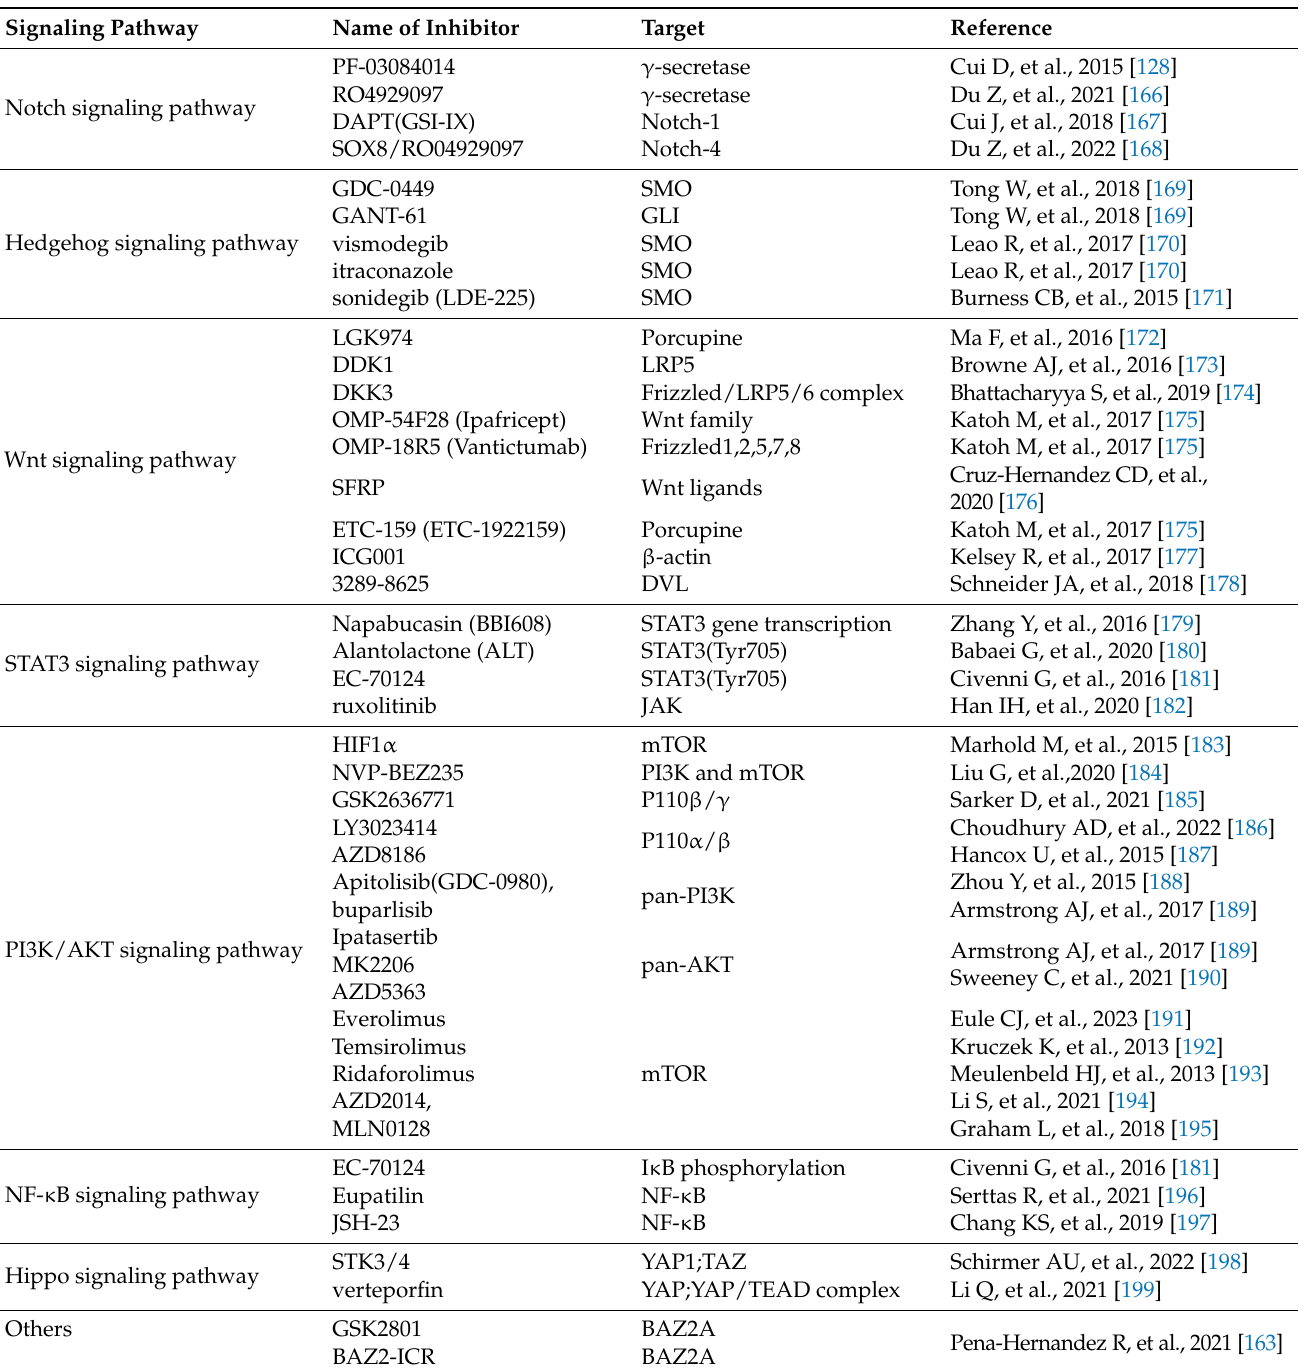
Table 2. Prostate cancer stem cells related